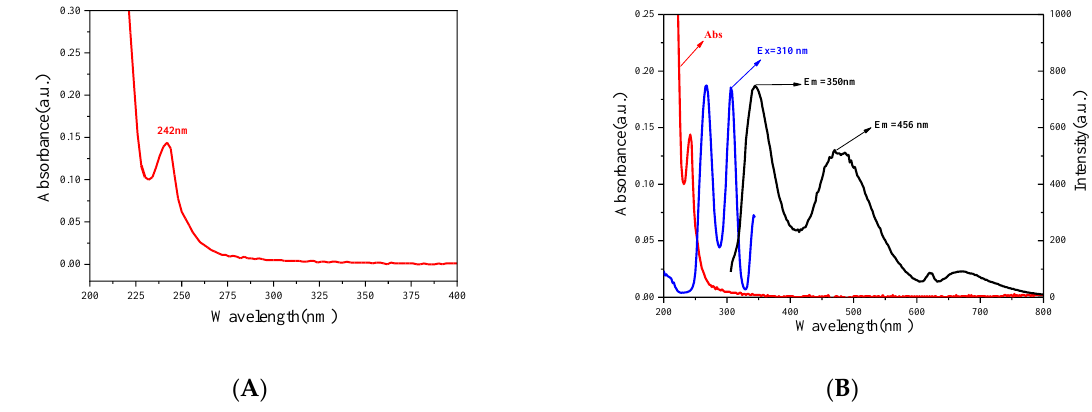
Figure 4. ( A ) UV-Vis absorption spectra of N-CDs; ( B ) fluorescence spectra of N-CDs.